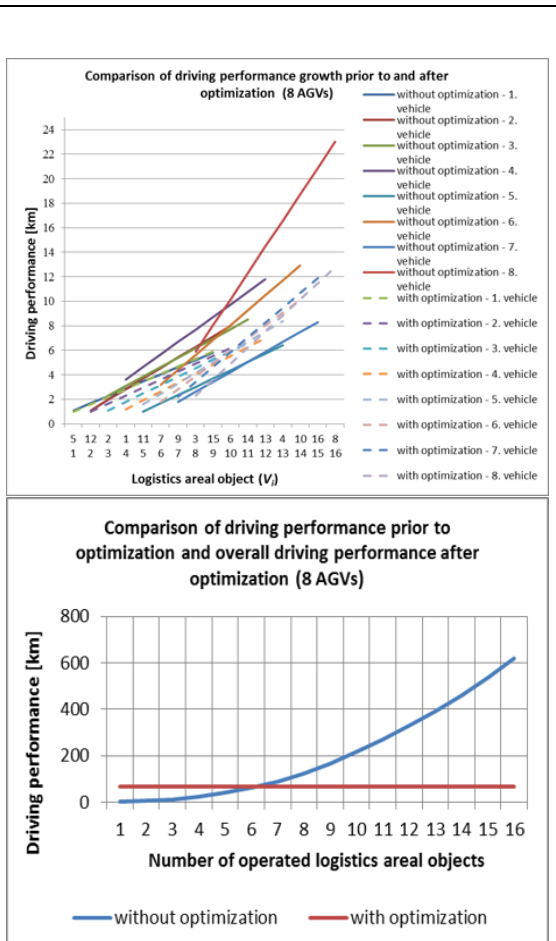
Figure 5: Course of driving performance prior to and after the dis- tance optimization when using six AGVs to operate individual buildings ( Vi ) is ∑︀ n (veh. 1 = 27.3 km; veh. 2 = 30.3 km; veh. 3 = 33.9 km and veh. 4 = 36.0 km).